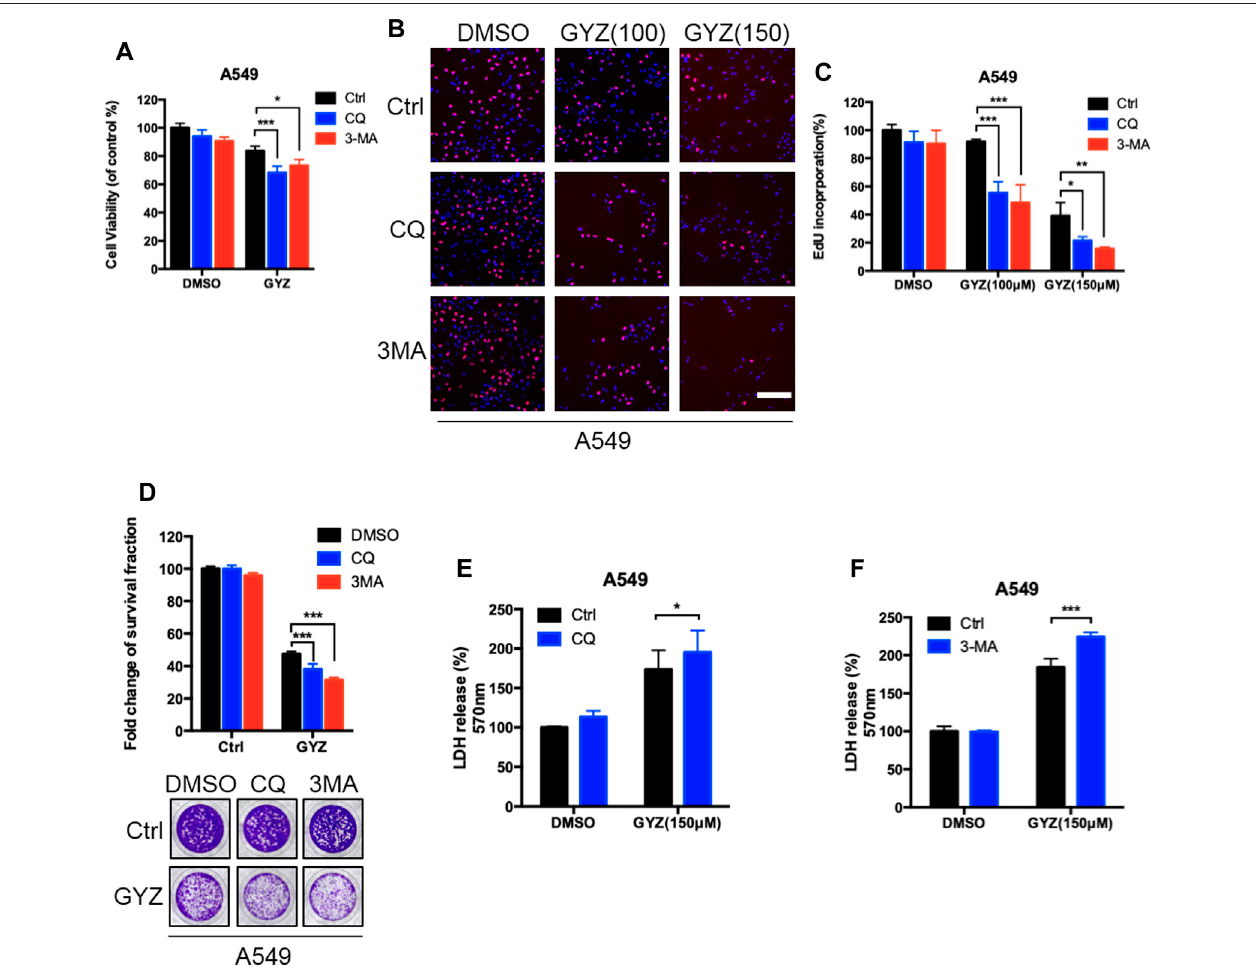
FIGURE 5 | Inhibition of autophagy augments the antitumor activity of GYZ in NSCLC cells. (A) A549 cells were treated with 3-MA (10 mM) or CQ (5 μ M) in the absenceorpresenceofGYZ(100 μ M)for48 h.Cellgrowth wasevaluatedbyMTTassay. (B,C) A549CellsweretreatedwiththeindicatedconcentrationsofGYZinthe absence or presence of 3-MA (10 mM) or CQ (5 μ M). Cell proliferation was detected by EdU incorporation assay. (D) A549 cells were treated with CQ (5 μ M) or 3-MA (10 mM) in the absence or presence of GYZ (150 μ M) for 2 weeks. Cell proliferation was performed by colony-formation assay. E, F) A549 cells were treated with 3-MA (10 mM) or CQ (5 μ M) in the absence or presence of GYZ (150 μ M) for 48 h. The cytotoxicity was examined by the release of LDH. All data are means ± SD. * p < 0.05, ** p < 0.01, *** p <